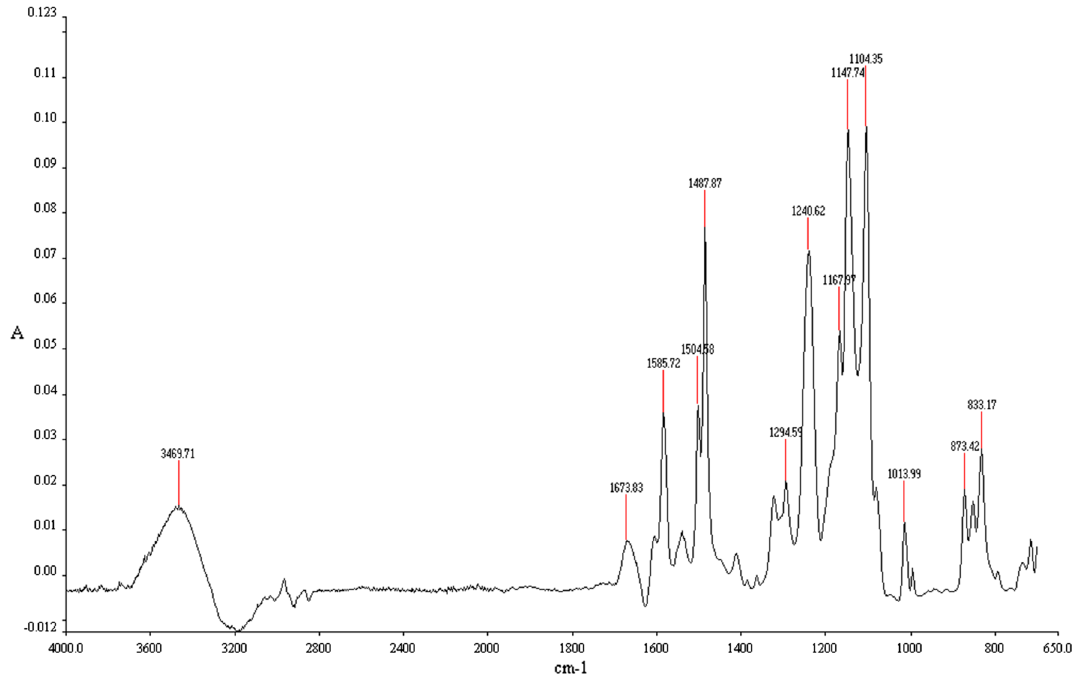
Fig. 10 Difference ATR/FTIR spectra of Koch